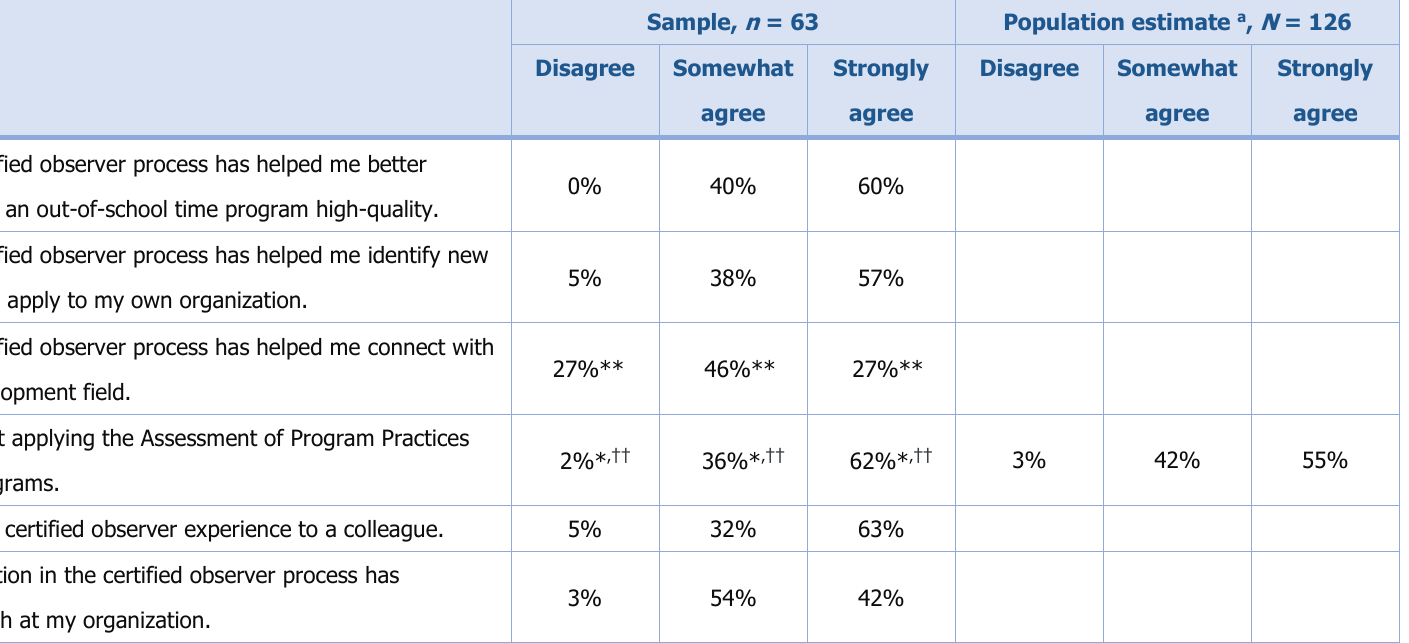
Table 3. Actual and Adjusted Impact on Participants and Perceived Impact on Youth